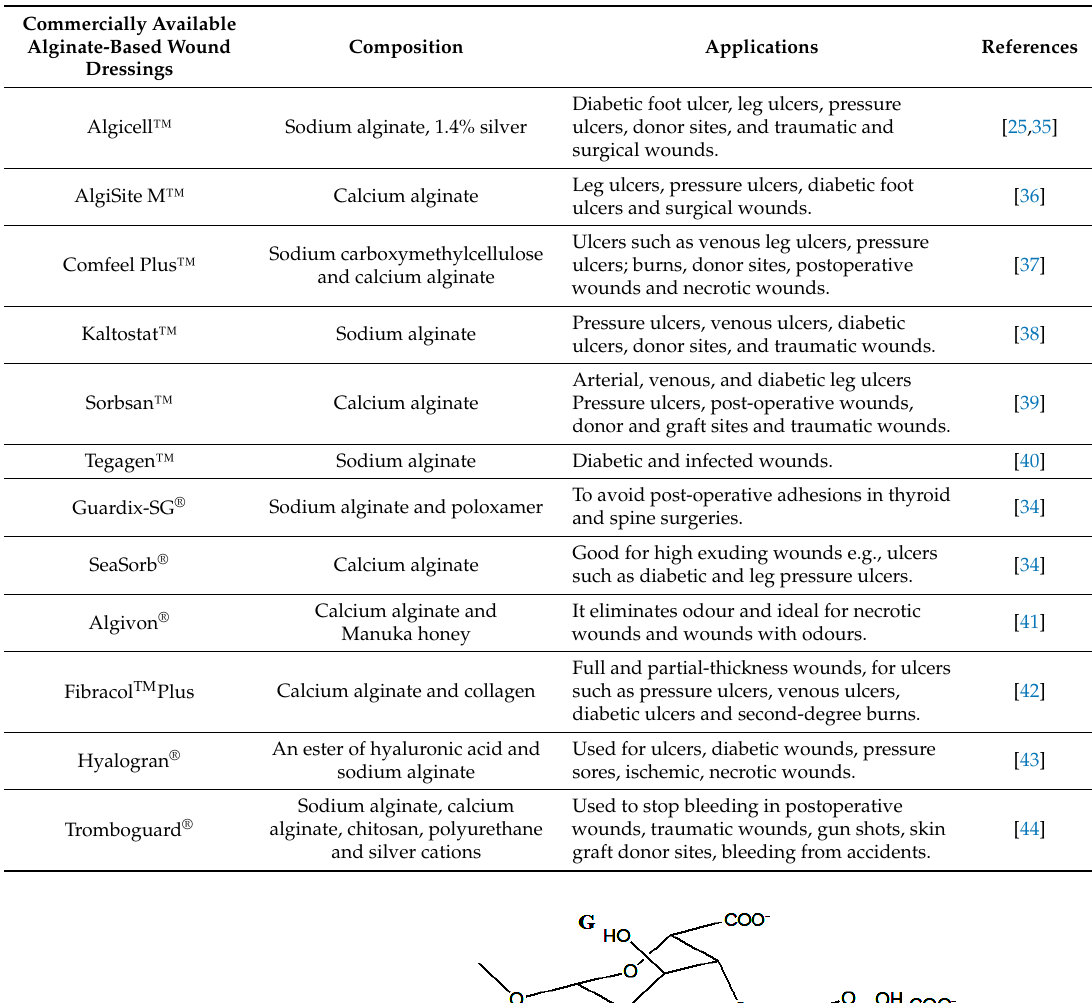
Table 2. Commercially available alginate-based dressings.